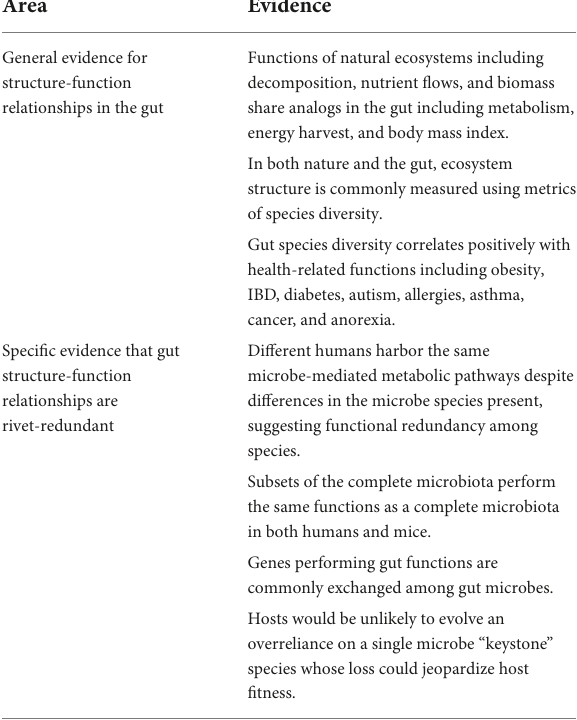
TABLE 1 Lines of evidence supporting a rivet-redundancy relationship between species diversity (structure) and health (function) in the human